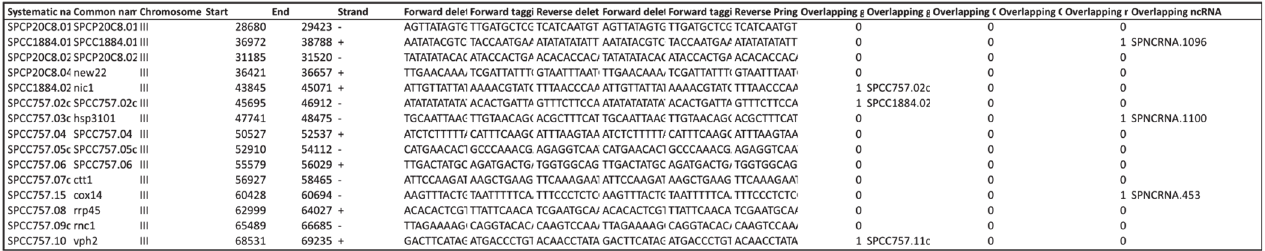
Figure 2. An example of a PRIMED database (fission yeast CDS). In all databases, we provide the systematic and common names, chromosome number, start/end coordinates, transcription strand and forward and reverse primer sequences for each feature under consideration. For deletion databases, also the name(s) and total number of overlapping ORFs, which are disrupted by creating the gene deletion, are